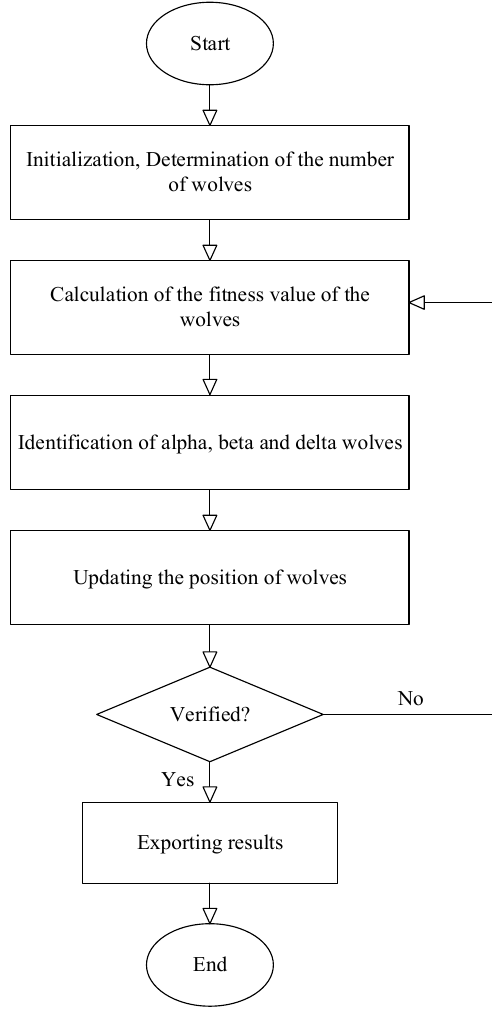
Figure 4. Grey wolf optimizer (GWO) algorithm.